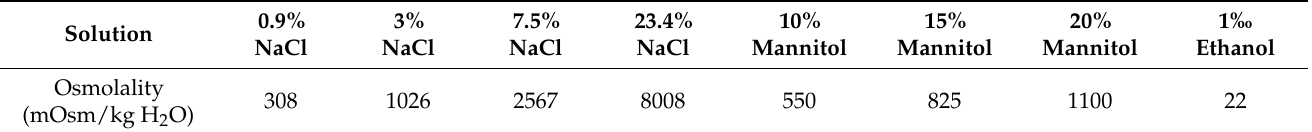
Table 1. Theoretical osmolality of the most popular osmotically active agents [17–25].